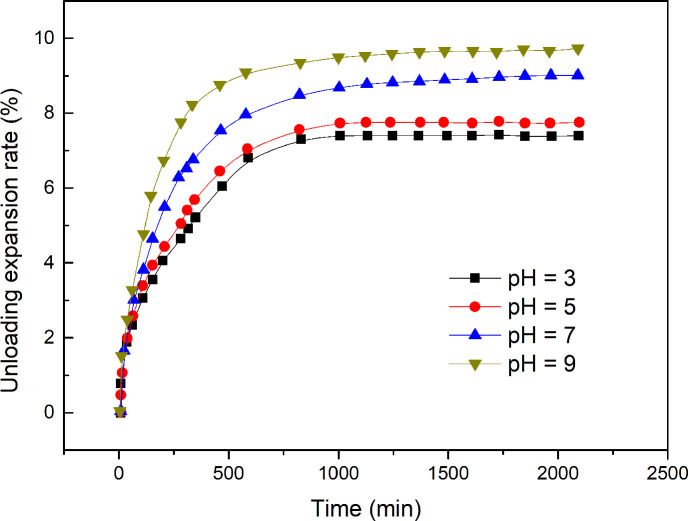
Time-dependent unloading expansion rate of expansive soils at different soil pH values.